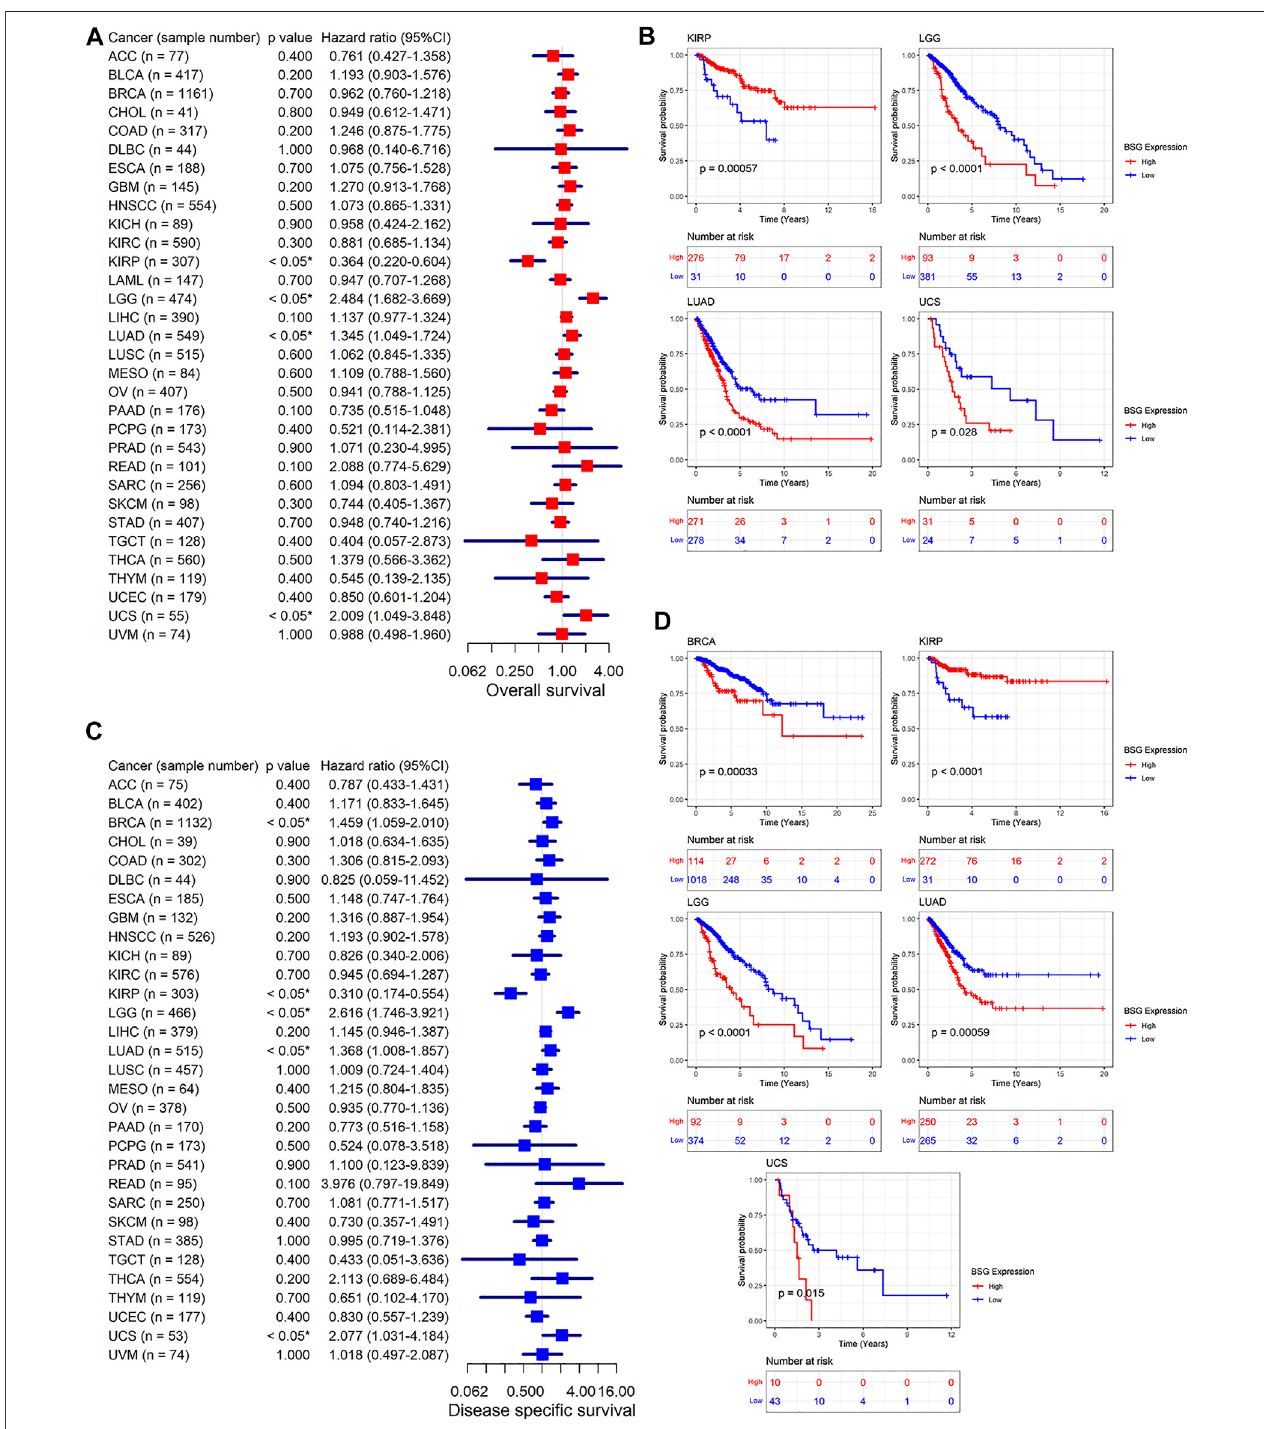
FIGURE 4 | Relation of BSG expression with overall survival ( (A – B) ) and disease-speci fi c survival of cancer patients ( (C – D) ). (A,C) Forest plots produced by univariate Cox regression analysis. (B,D) Kaplan – Meier curves with p -values based on log-rank tests. The optimal cut point for high and low expression levels of BSG in eachKaplan – Meiercurvewasidenti fi edusingthemaximallyselectedrankstatisticsfromthe “ maxstat ” and “ survminer ” Rpackages.InAandC,thevalueinparentheses (e.g., “ n = 77 ” for ACC) represents the number of samples. ACC, adrenocortical carcinoma; BLCA, bladder cancer; BRCA, invasive breast carcinoma; CHOL, cholangiocarcinoma; COAD, colon adenocarcinoma; DLBC, lymphoid neoplasm diffuse large B-cell lymphoma; ESCA, esophageal carcinoma; GBM, glioblastoma multiforme; HNSCC, head and neck squamous cell carcinoma; KICH, kidney chromophobe; KIRC, kidney renal clear cell carcinoma; KIRP, kidney renal papillary cell